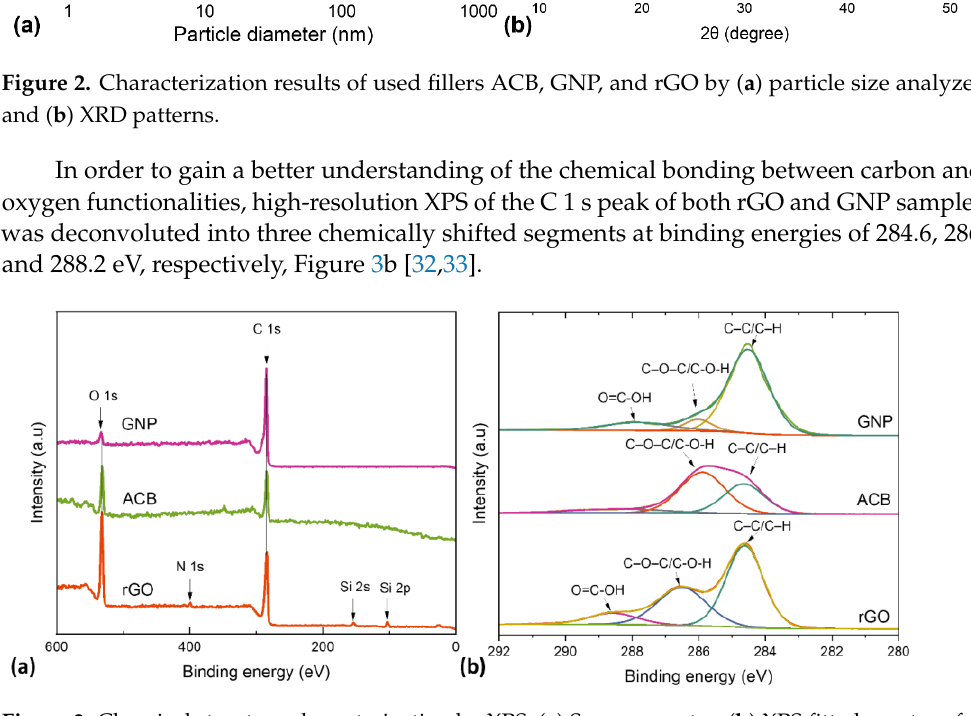
Figure 3. Chemical structure characterization by XPS: ( a ) Survey spectra; ( b ) XPS fitted spectra of C (1S) of rGO, ACB and GNP powder. Table 1. Chemical composition (atomic %) determined using XPS.